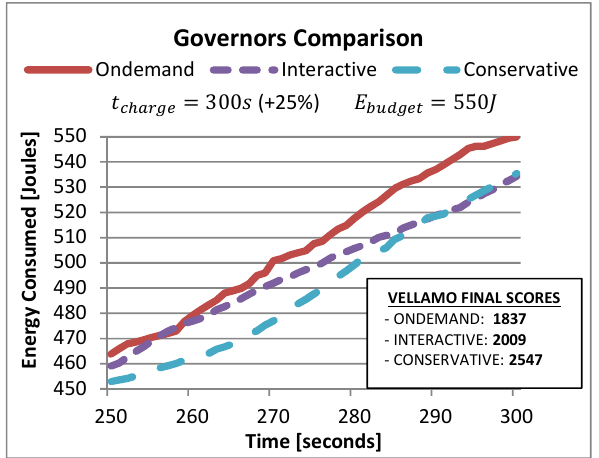
Figure 10. Comparison of different frequency